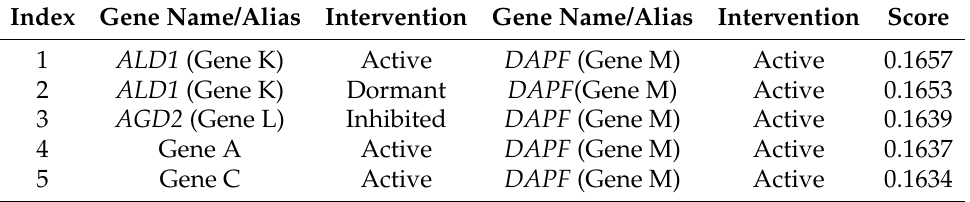
Table 1. Top five pairwise intervention strategies under normal conditions.